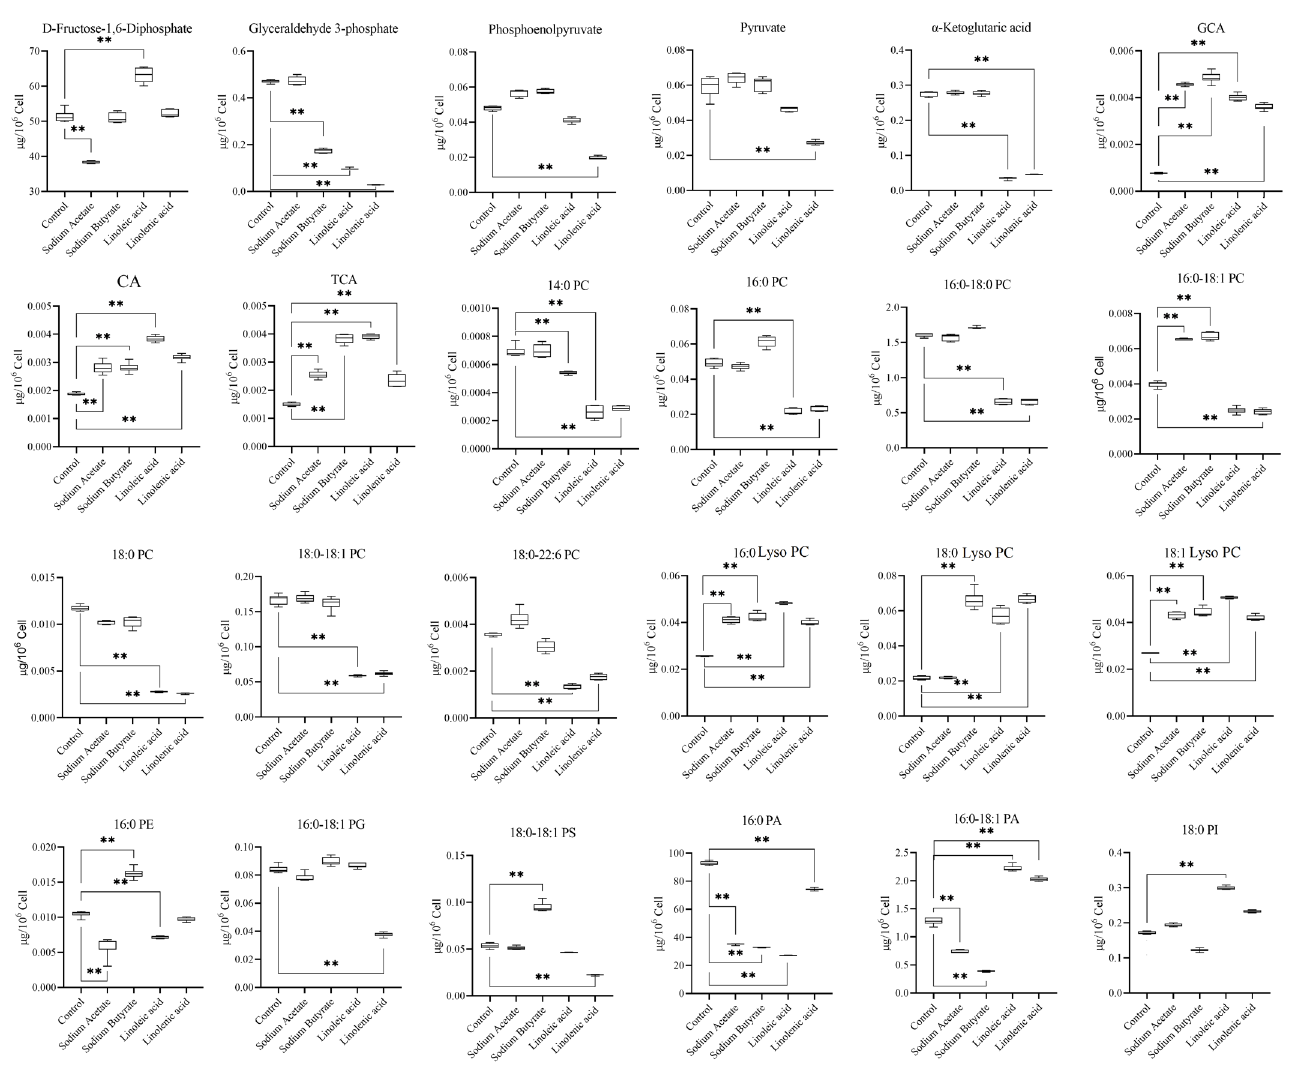
Figure 7. Box plot representing the differential metabolites in targeted metabonomics. **: p value < 0.01.